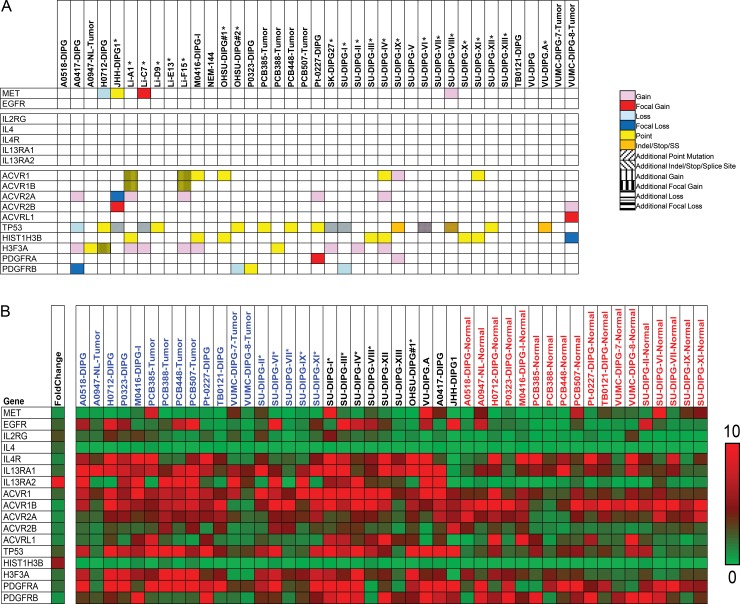
Landscape of exome mutations and differential gene expression of frequently-mutated DIPG genes and IL-4 pathway targets in DIPG samples.(A) Mutational landscape of frequently-mutated DIPG genes and IL-family genes. Exome sequencing was performed on 38 DIPG samples to identify somatic mutations and copy number variations. When possible, tumor samples were compared against matched normal samples. (B) Gene expression of frequently-mutated DIPG genes and IL-family genes. The set of genes is identical to those in Fig A. RNA sequencing was performed on 28 DIPG samples: 18 tumor samples with matched normal samples, 10 unmatched tumor samples. Average fold change and tumor vs. normal p-values were calculated across the set of expressed genes. Note that IL-13Rα1 and IL-13Rα2 are significantly overexpressed in tumor compared to normal, but are mutationally silent.